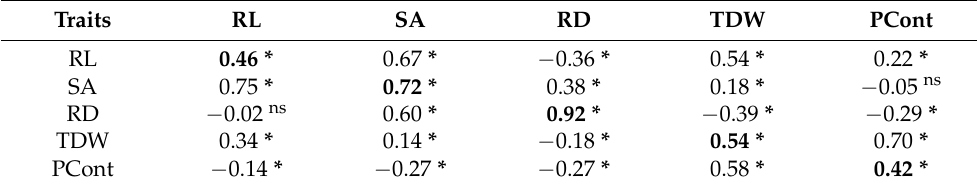
Table 2. Pearson correlation coefficients among root length (RL), root surface area (SA), average of root diameter (RD), total seedling dry weight (TDW) and total P content (PCont) for 561 maize lines. Correlation coefficients along the diagonal are between low- and high-P levels for each trait. Values below diagonal are the correlations between traits evaluated under low-P levels. Above diagonal numbers are the correlations between traits evaluated under